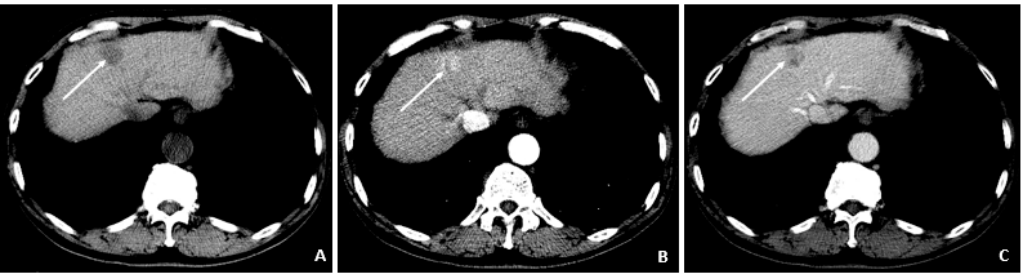
Figure 5. Triphasic CT at the time of HCC diagnosis (March 2009). ( A ) The precontrast image shows a hypodense lesion (arrow) at the site of the punctate hyperenhancing lesion shown in Figure 4. ( B ) The corresponding arterial-phase postcontrast image reveals hyperenhancement (arrow). ( C ) The portal-phase postcontrast image shows washout (arrow), and all features are typical of HCC and confirm the diagnosis in the setting of chronic HBV.